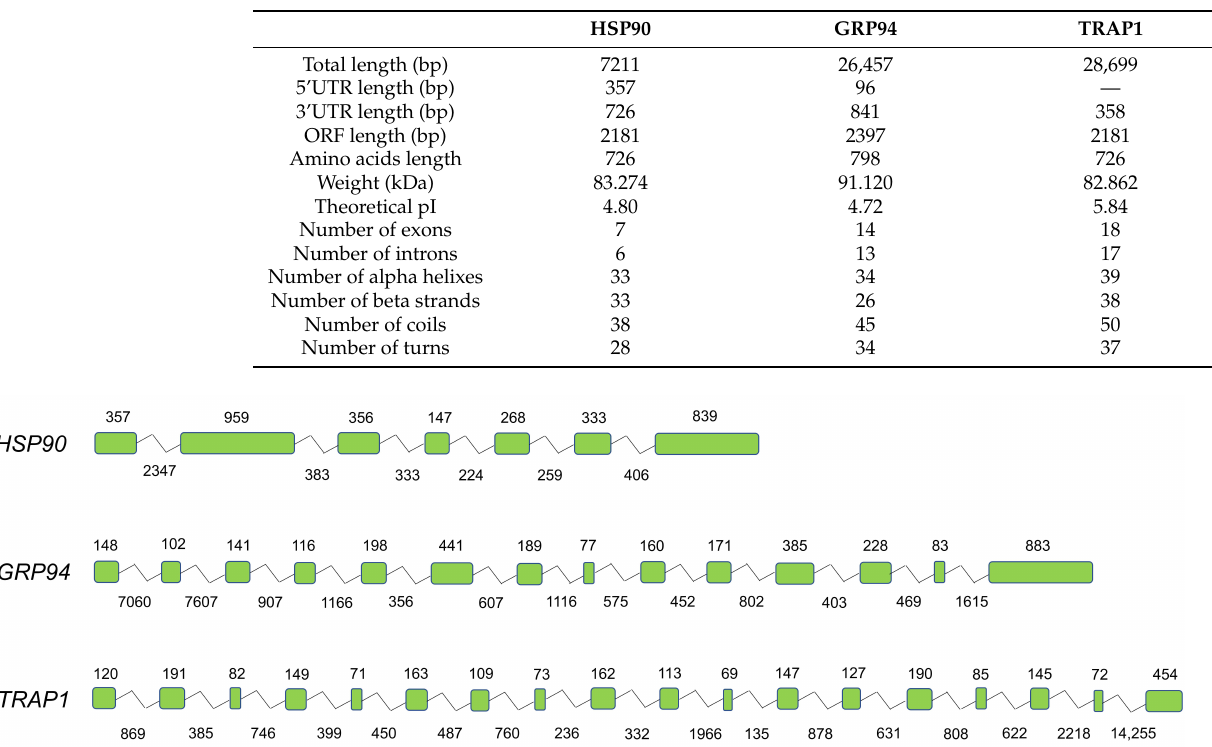
Table 1. Characteristics of HSP90s in C. farreri .